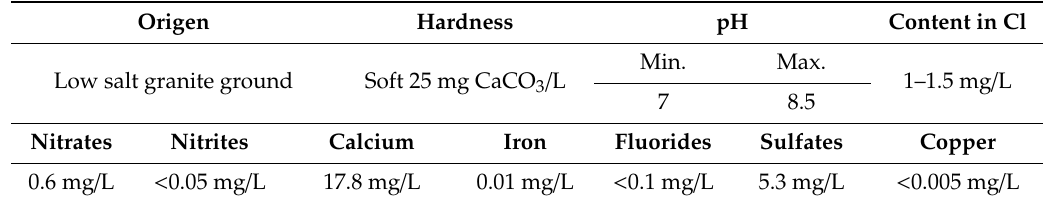
Table 4. Characteristics and chemical analysis of water in the Community of Madrid [51].